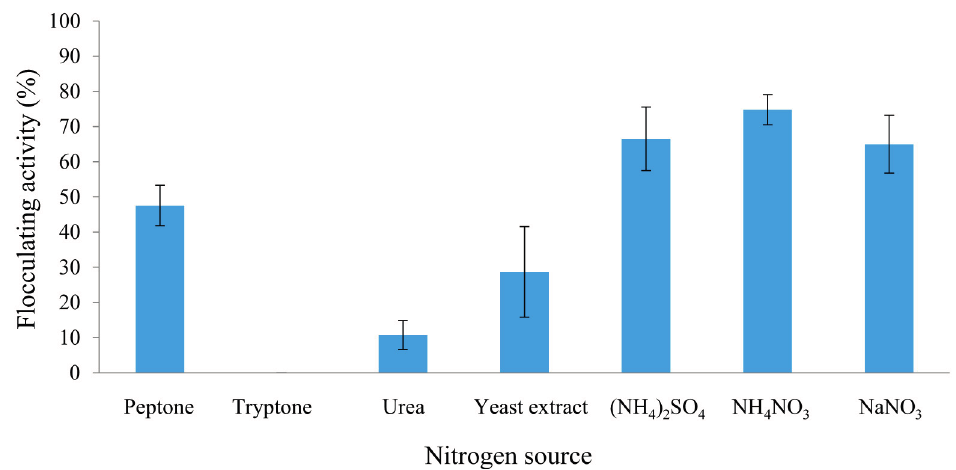
Figure 2. Effect of Nitrogen Source on REG-6 Production by Bacillus toyonensis strain